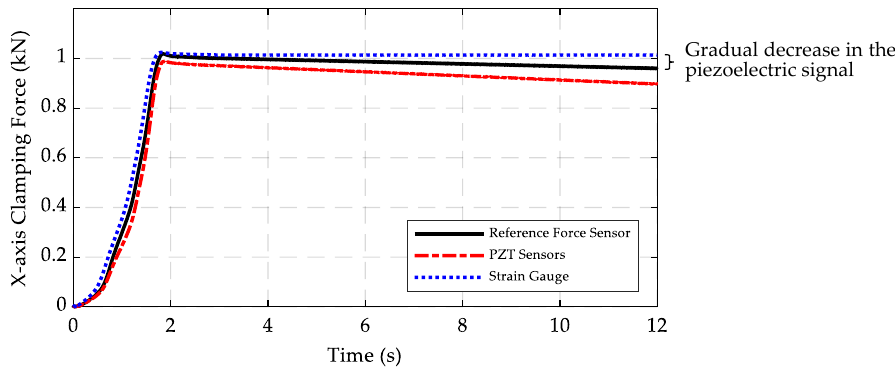
Figure 18. Results of strain gauge and PZT sensors compared with the result for the reference piezoelectric force